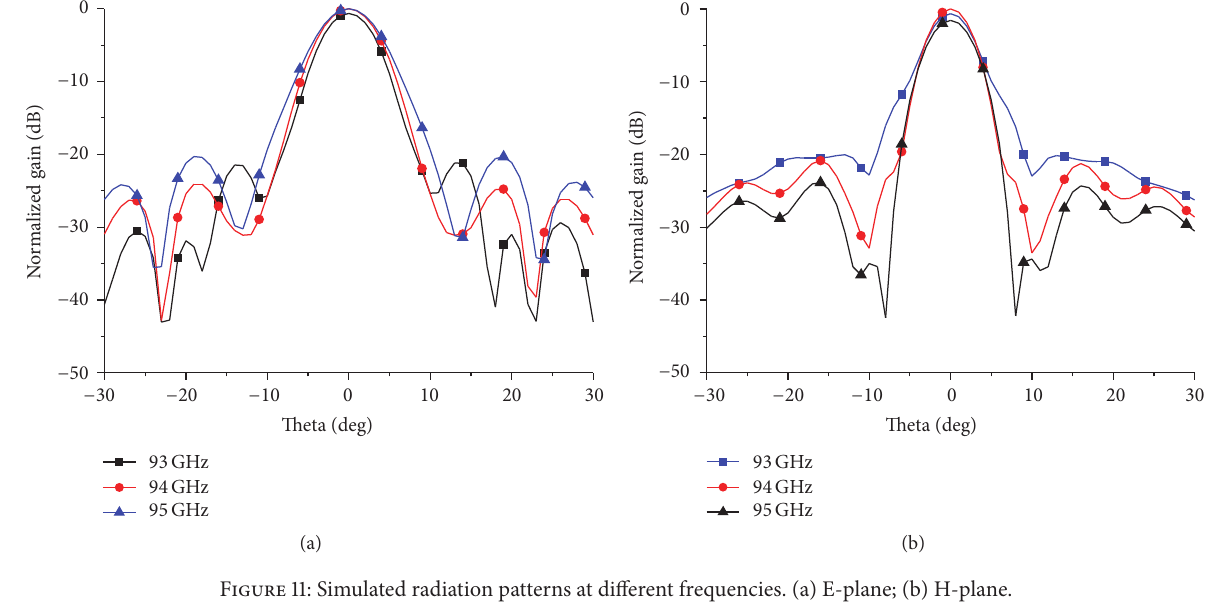
Figure 11: Simulated radiation patterns at different frequencies. (a) E-plane; (b) H-plane.